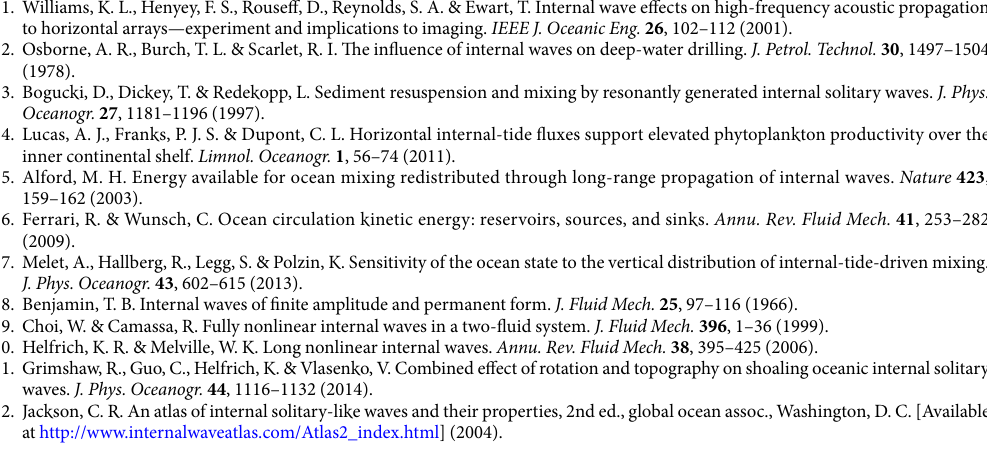
20. The horizontal viscosity was set to 300 m 2 s − 1 . Climatological variations of discharges from the Changjiang River and the Huanghe River were included as freshwater sources. Tidal effects were included in the numerical simulations along the open boundary using eight major tidal components derived from TPXO6 33 . Meteorological data predicted by the Korea Meteorological Administration were used to calculate surface wind stress and surface heat flux. The calculated tides were verified through comparisons with observations from tidal stations located at the IORS from April 2015 to June 2015 (Fig. 2e). Further details of the ROMS follow previous literatures 27 .